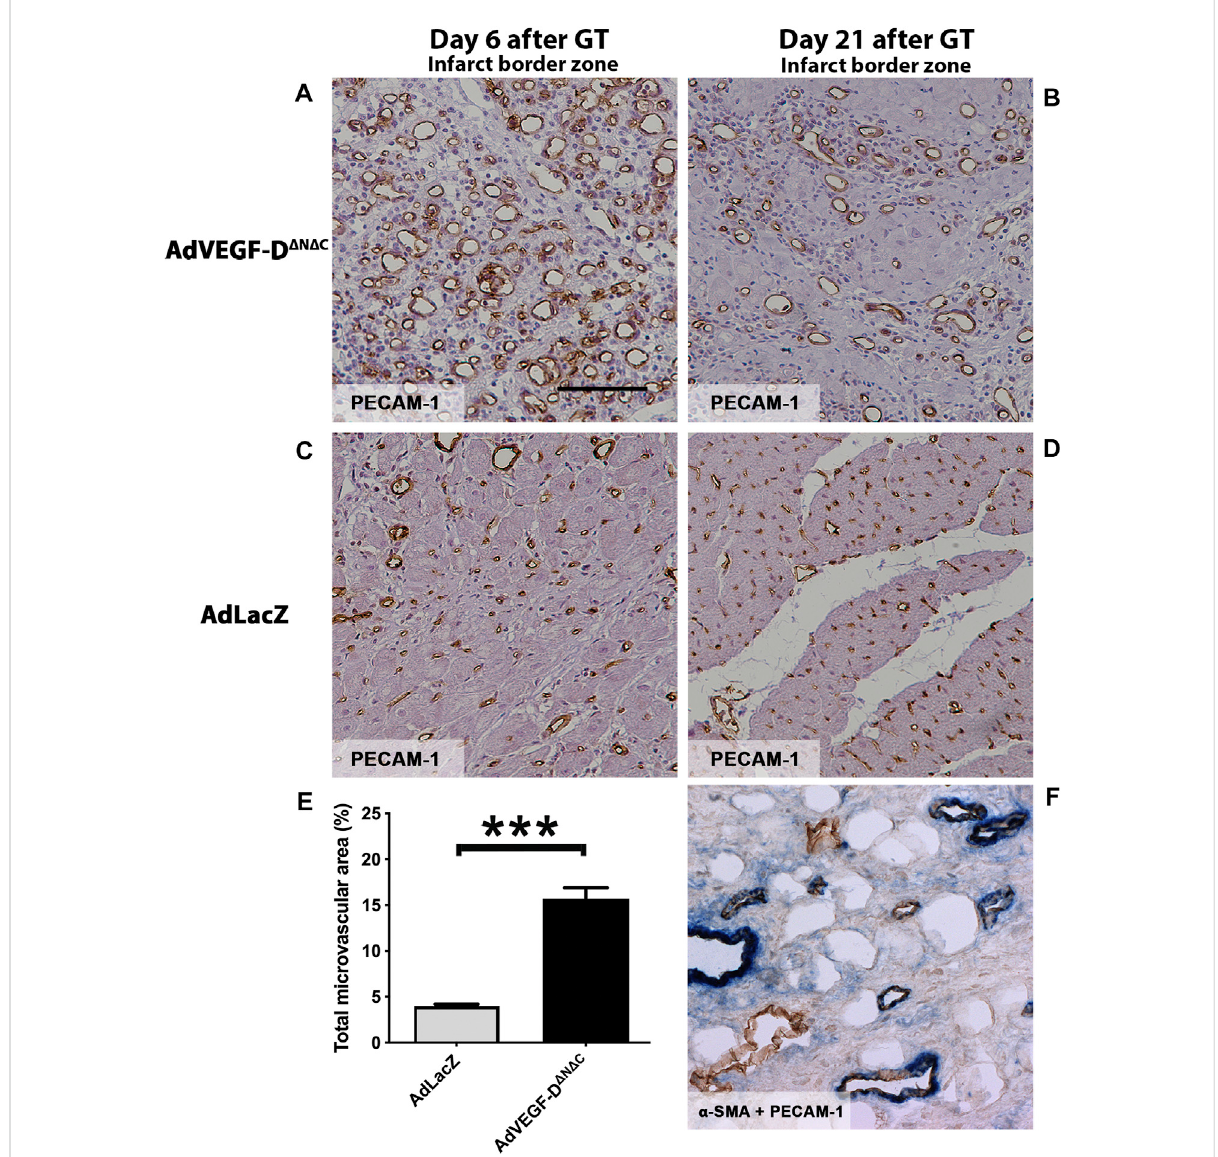
FIGURE 2 AdVEGF-D Δ N Δ Cinducesangiogenesisintheischemicporcineheart. (A) AdVEGF-D Δ N Δ C inducedrobustangiogeniceffect6 daysafterthegene transfer (GT). (B) 21 days after the AdVEGF-D Δ N Δ C gene transfer the angiogenic effect was still present. (C,D) AdLacZ gene transfer did not induce angiogenesis. (E) The graph shows the total microvascular area (%) on day 6. The difference between the groups was statistically signi fi cant ( p < 0.001). (F) Double immunostaining α -SMA + PECAM-1 to show pericytes around the vessels on day 21 in AdVEGF-D Δ N Δ C group. PECAM-1 - brown color, α -SMA – blue color. PECAM-1 staining for infarct border zone samples, magni fi cation ×200, scale bar 100